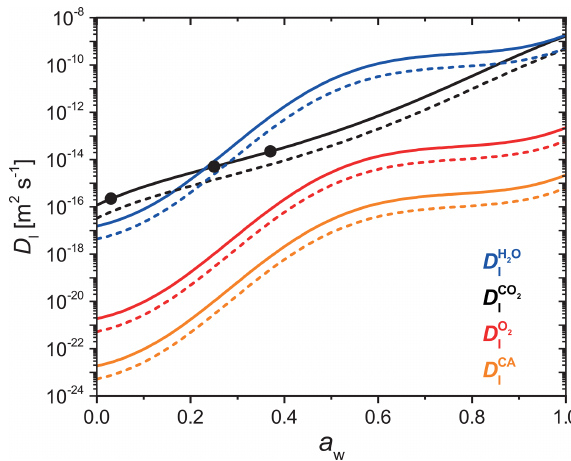
Figure A1. Parameterized liquid phase diffusion coefficients of H 2 O (blue), CO 2 (black), O 2 (red), and CA (orange) as a function of water activity at Fe III ( Cit )/ CA molar ratio of 0.05 (solid lines) and 1.0 (dashed lines). The three black dots are measured CO 2 dif- fusivity in a Fe III ( Cit )/ CA particle with a molar ratio of 0.05 (Dou et al., 2019). These parameters are given for a temperature of 293.5